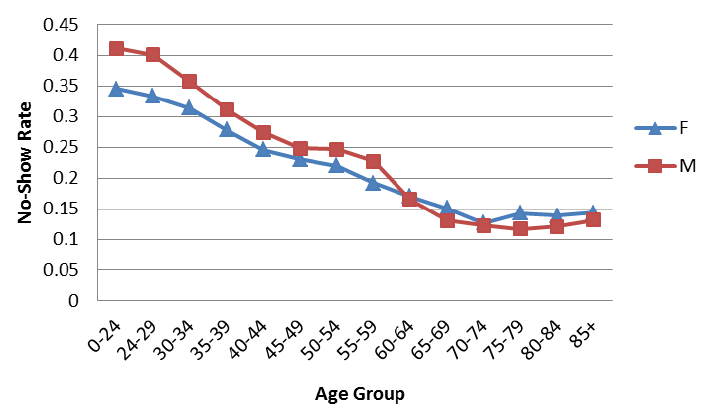
Figure 1. No-show rates by age group for all service lines.